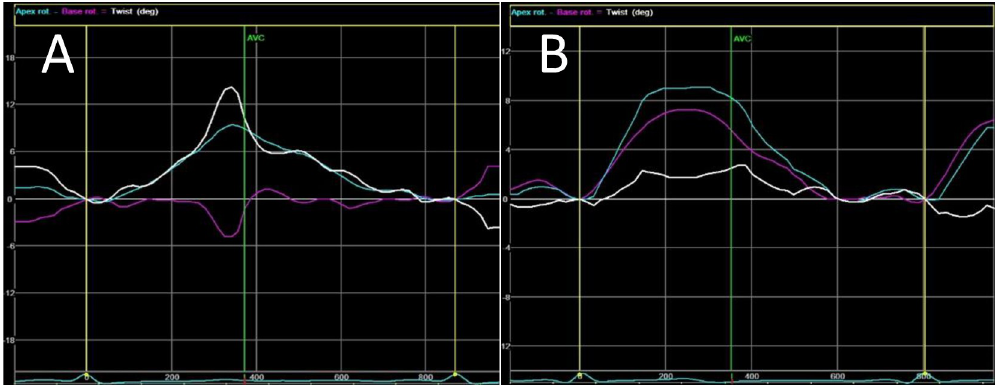
Fig 1. Apical rotation and basal rotation curve obtained from NCC patients. Normal left ventricular torsion (A), and rigid body rotation pattern (B). The green line represents the apex rotation, and the basal rotation is showed in pink, while the curves mean represented in white. Ordinate axis with positive value expresses counterclockwise rotation and with a negative value, clockwise rotation. AVC, aortic valve closure; LV twist = apical rotation–basal rotation (white line).